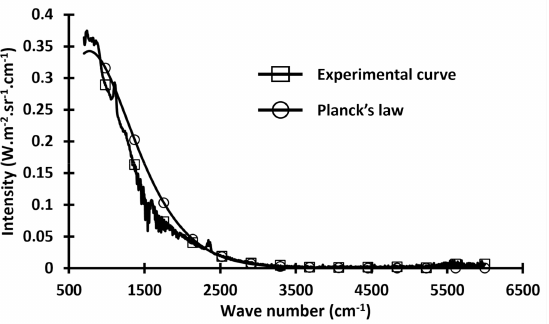
Figure 1. Spectral emission at a temperature of 393.28 K for a gray body and for a real